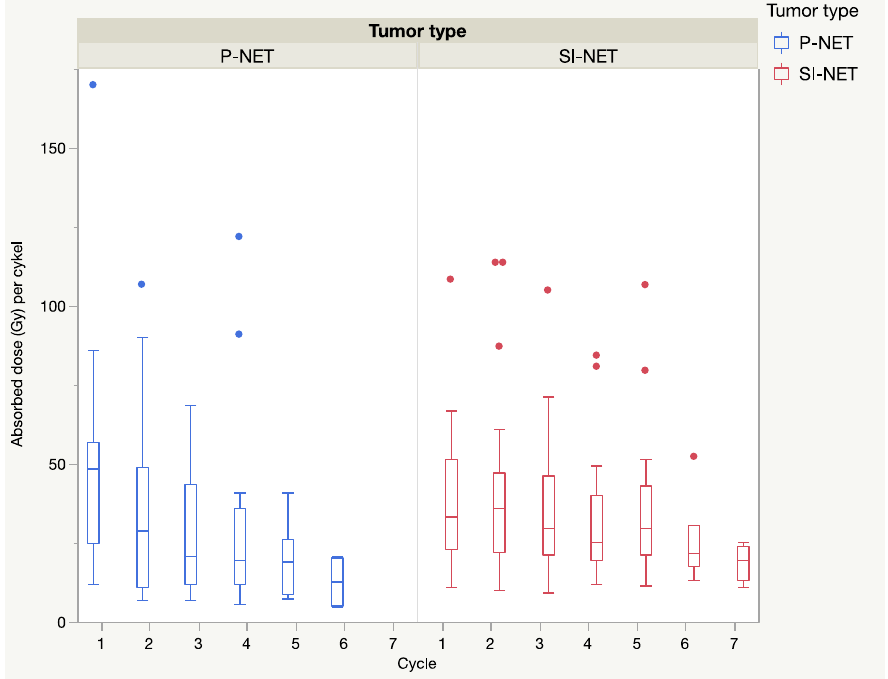
Figure 4. Tumor dose at each PRRT cycle. Median absorbed dose (Gy) in the measured tumors at each cycle. Full seven-day dosimetry cycles are shown together with 24 h dosimetry results. The absorbed tumor doses showed a continual decrease during the course of PRRT in both P-NENs ( n = 23) and SI-NENs ( n = 25).